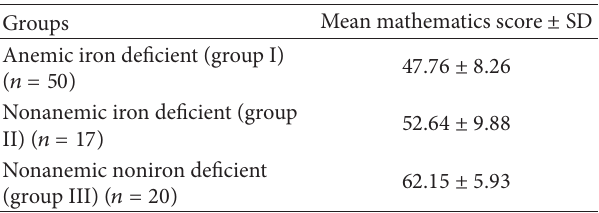
Table2:Themeanmathematicsscoreofthegirlstudentsindifferent groups.